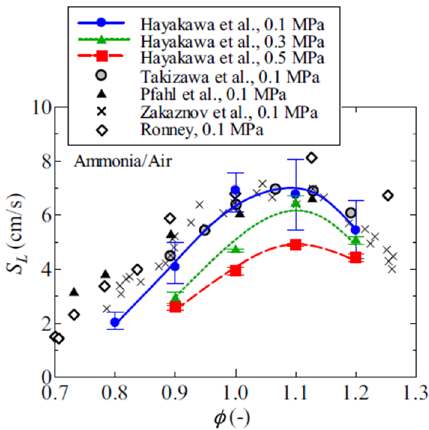
Figure 4. Experimental apparatus and results for measuring spherical flame propagation: ( a ) Schematic of experimental setup; ( b ) Direct and Schlieren images of NH 3 -air flame. Modified from [60]. Courtesy of Elsevier [60].